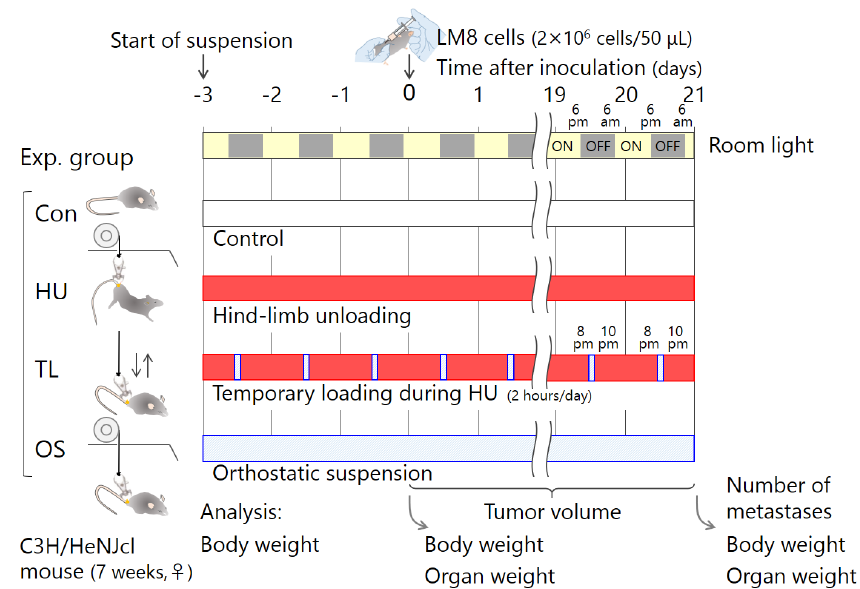
Figure 5. Schematic work flow for experiments. LM8 cells, a murine osteosarcoma line, were inoculated subcutaneously in C3H/HeNJcl mice 3 days after tail suspension under four conditions: Con, standard housing control; HU, hind-limb unloading; TL, temporary loading during HU (2 h per day); and OS, orthostatic suspension.